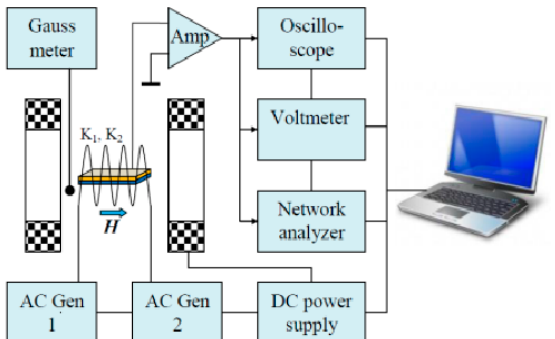
Figure 7. The multiferroic structure is placed in a uniform bias DC magnetic field. Alternating magnetic fields h 1 cos(2 π f 1 t ) and h 2 cos(2 π f 2 t ) with amplitudes h 1 , h 2 and frequencies f 1 , f 2 are created by two electromagnetic coils K 1 and K 2 , powered by two independent generators “AC Gen1” and “AC Gen2”. Figure reprinted with permission from [85].